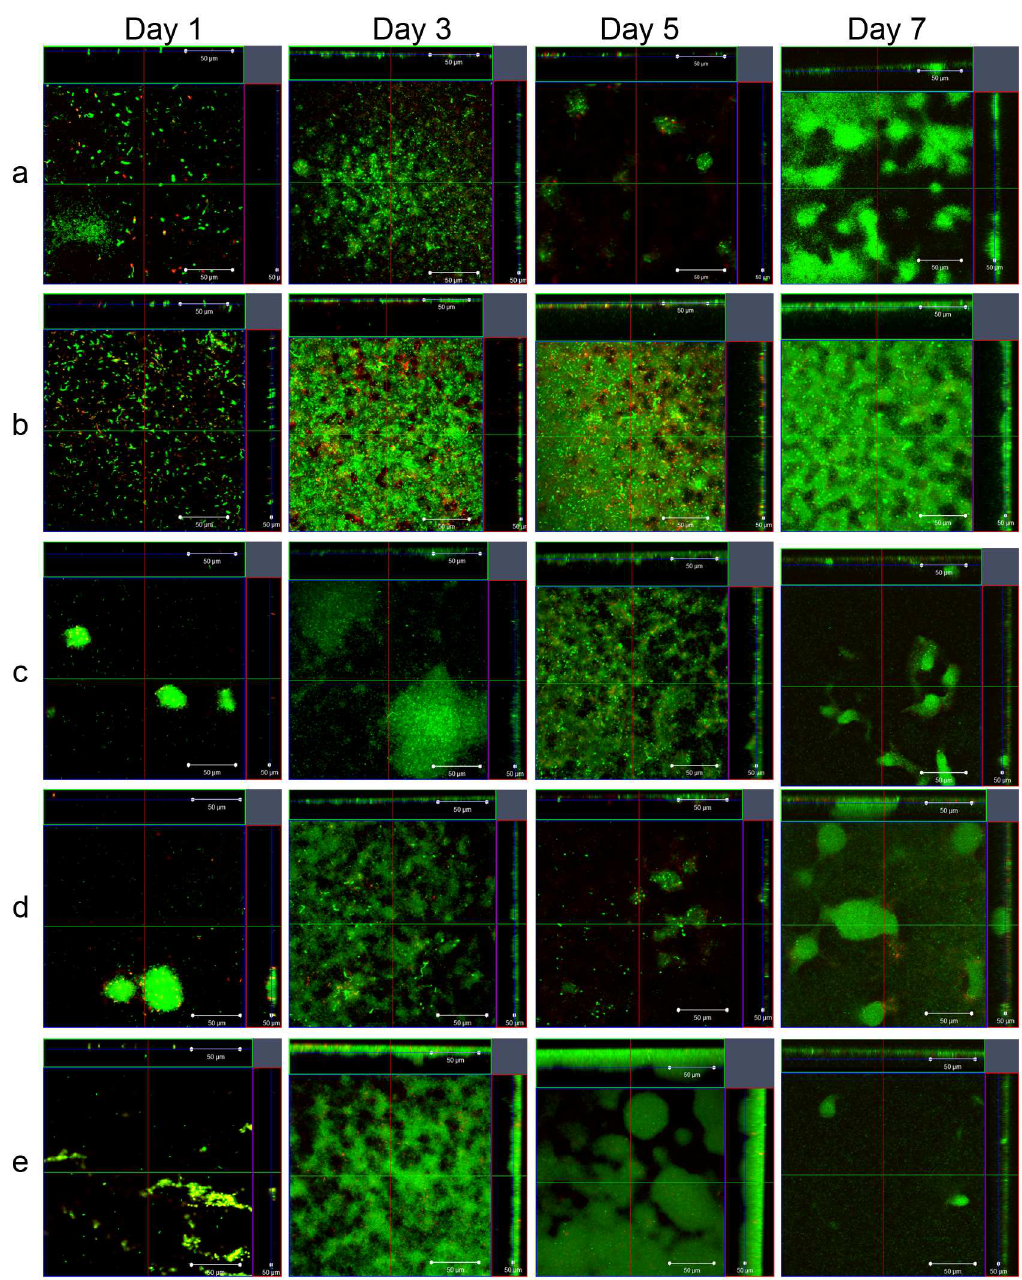
Fig 6. Influence of FliC phosphorylation on dynamic biofilms formed under flow cell conditions. Comparison of biofilm architecture in confocal-ortho view for PAO1 WT, Δ fliC , Δ fliC -FL T27A, Δ fliC -FL and Δ fliC -FL S28A strains across 7 days. Live and dead cells are representedin green and red, respectively. Panels are representedas a-WT, b- Δ fliC , c- Δ fliC - FL T27A, d- Δ fliC -FL and e- Δ fliC -FL S28A, respectively. Magnification is under 40X oil lens. Scale bars indicate a distance of 50 μ